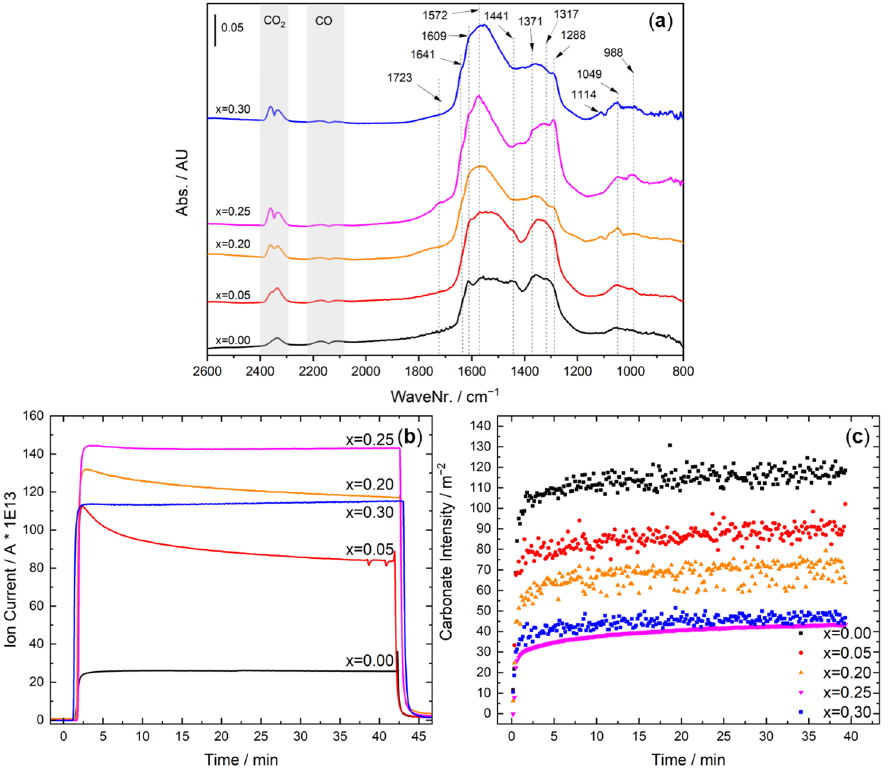
Figure 7. ( a ) DRIFTS spectra of the selected 20% O 2 -treated catalysts after 40 min of exposure to the reaction mixture of 0.2%CO + 2% O 2 in He at 200 °C. The labels represent the Co content in the catalysts. ( b ) MS CO 2 traces during the isothermal holding period in the reaction mixture of 0.2% CO + 2% O 2 balanced in He. ( c ) Integrals of the carbonate region normalized on exposed BET surface area in the spectra during the experiment in the reaction mixture of 0.2% CO + 2% O 2 balanced in He.